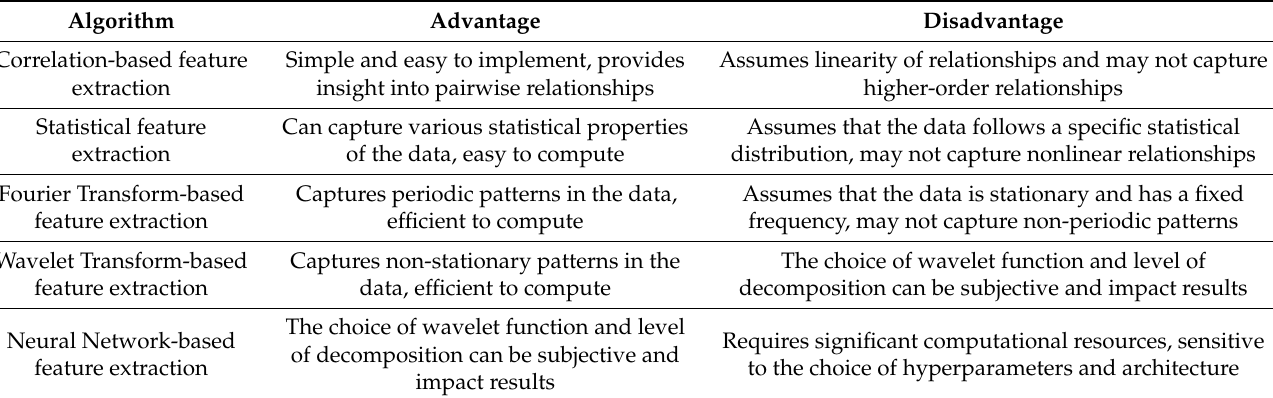
Table 7. Comparison of the proposed method with other existing feature extraction